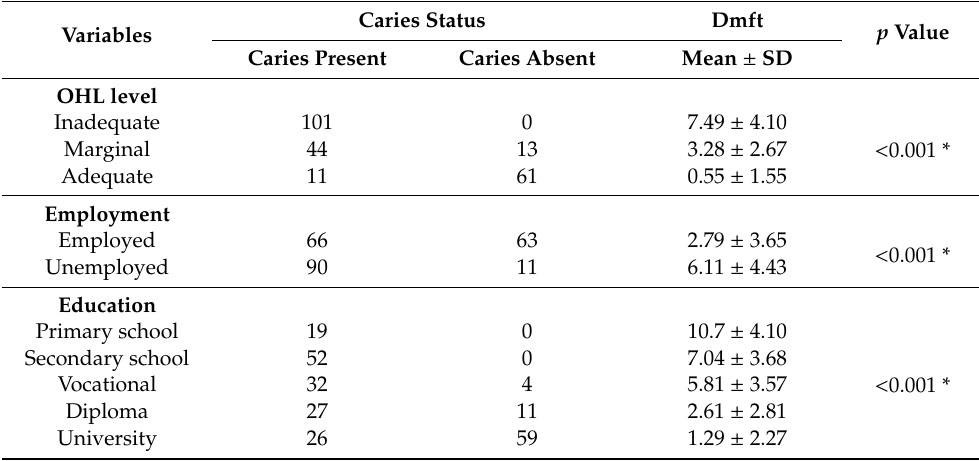
Table 2. Mean decayed, missing, filled teeth (dmft) score of preschool children in relation to the oral health literacy (OHL) level of